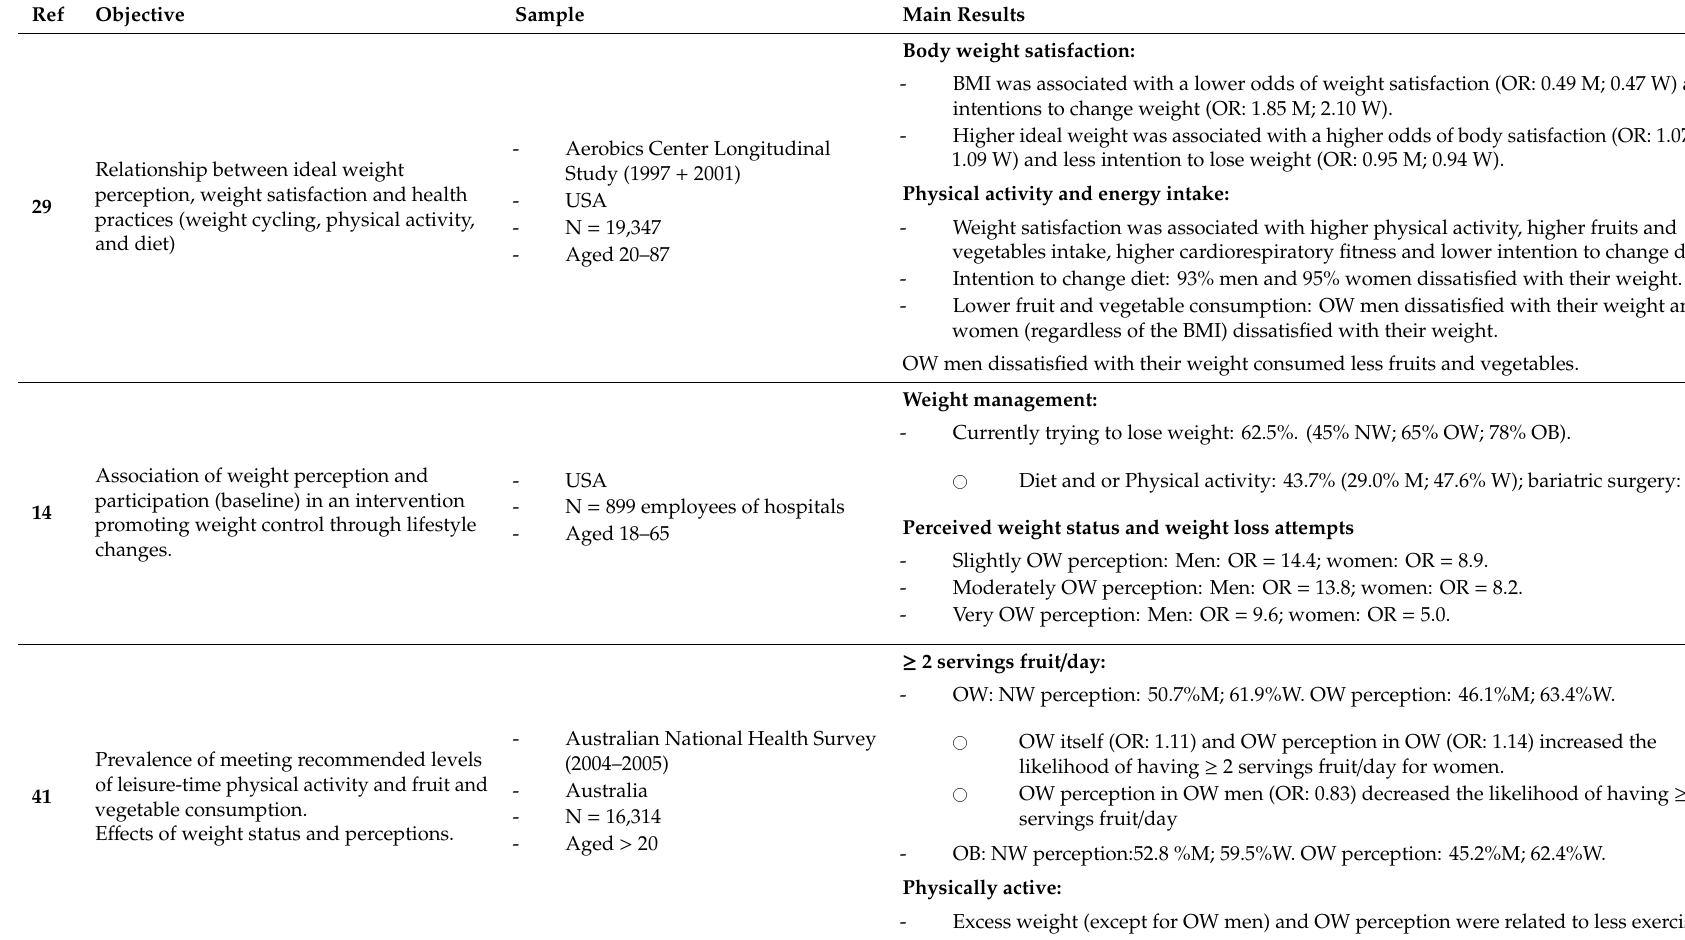
Prevalence of meeting recommended levels of leisure-time physical activity and fruit and vegetable consumption. E ff ects of weight status and